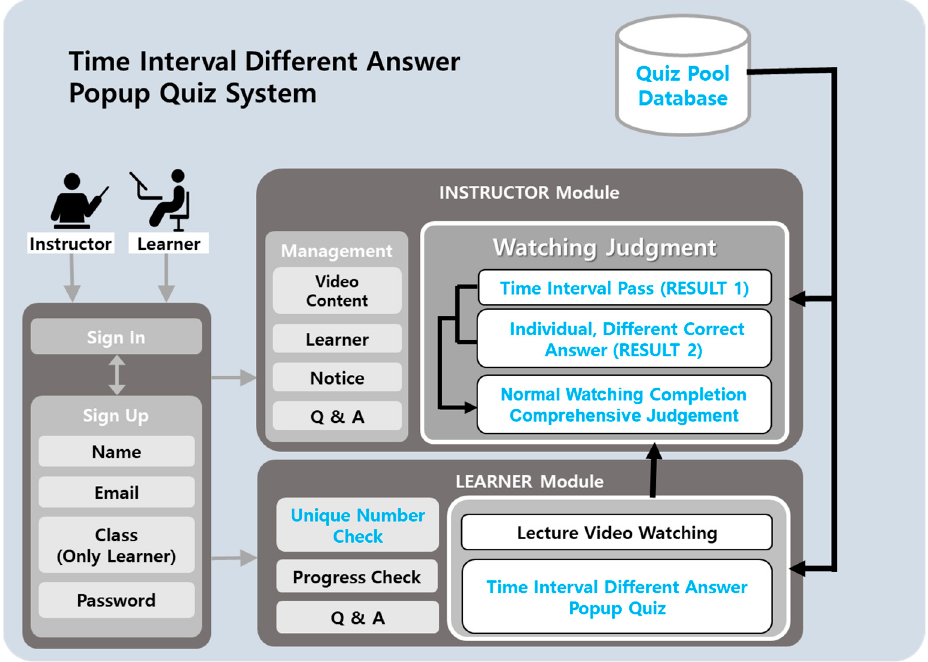
Figure 3. Systems with Time Interval Different Answer Popup Quiz (TIDAPQ) Model.